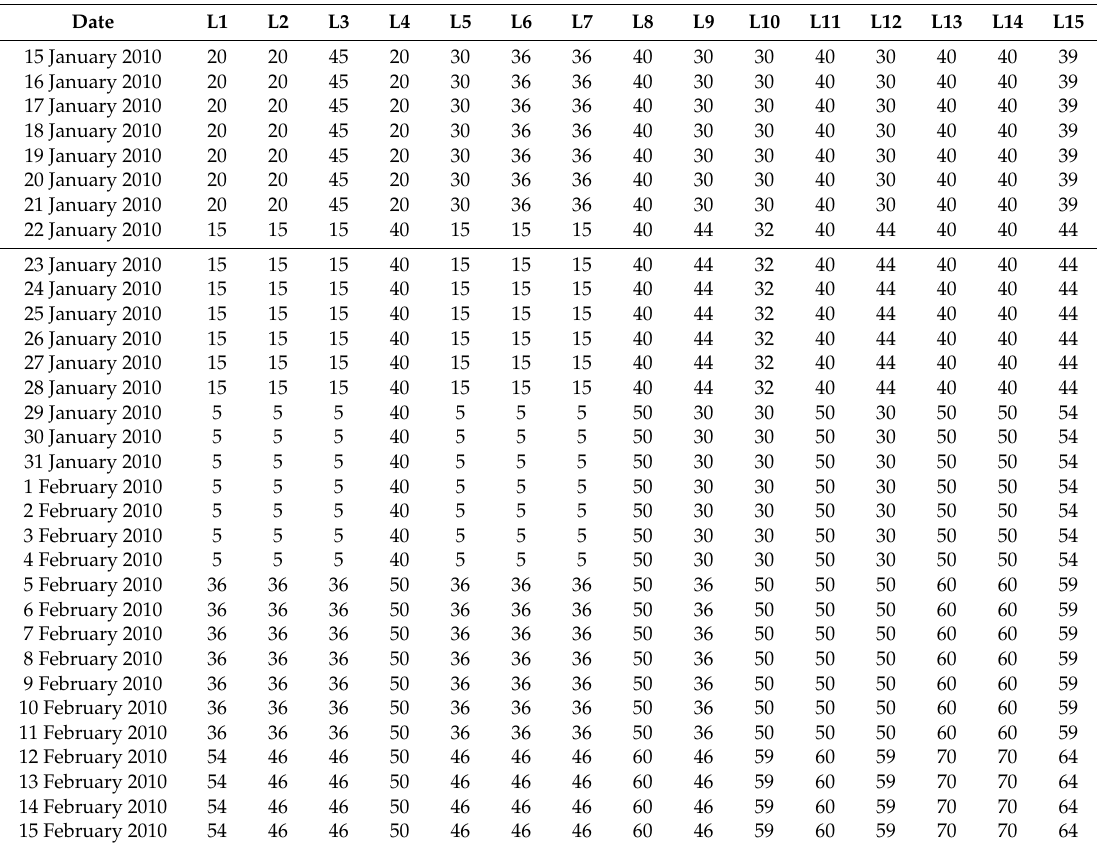
Table A4. H eq _ max (cm) determined by date and leg